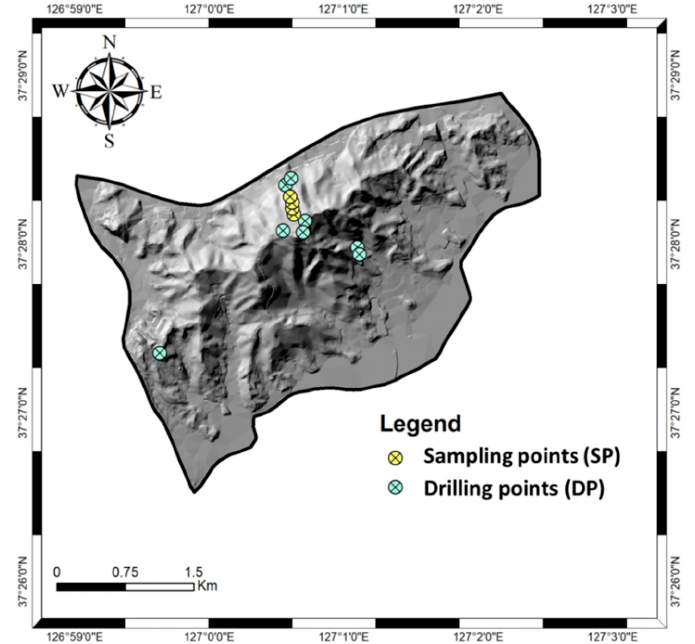
Figure 5. Location map of sampling point for acquisition of geotechnical properties.